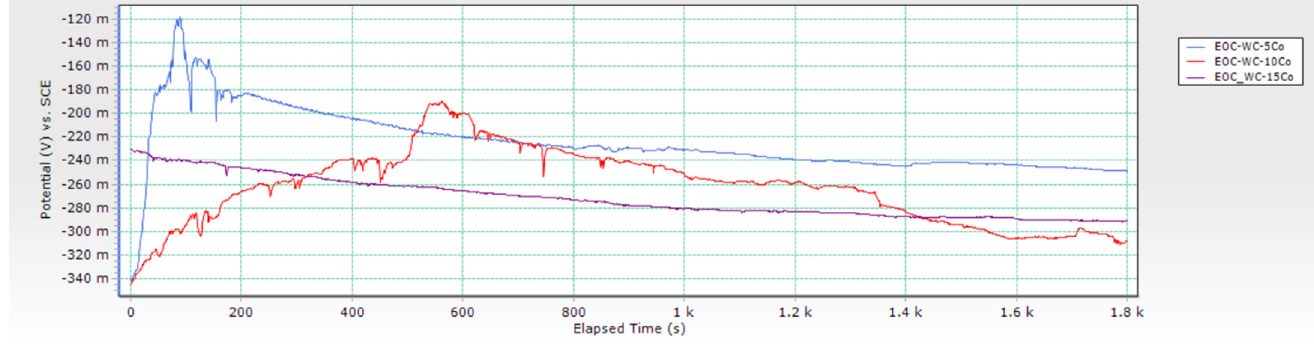
Figure 5. Corrosion potential E corr of samples.